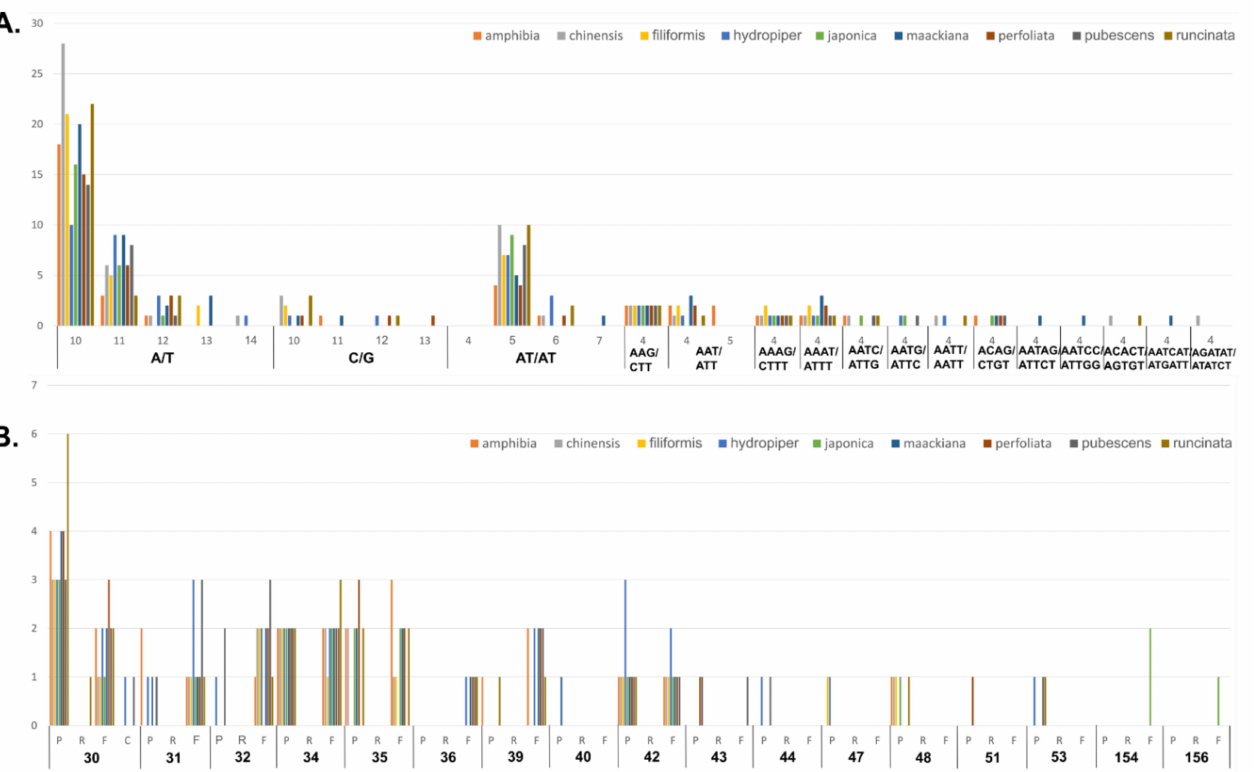
Figure 4. Analyses of repeat sequences in the Persicaria chloroplast genomes. ( A ) Frequency of SSRs determined by the MISA program. ( B ) Frequency of repeat sequences determined by